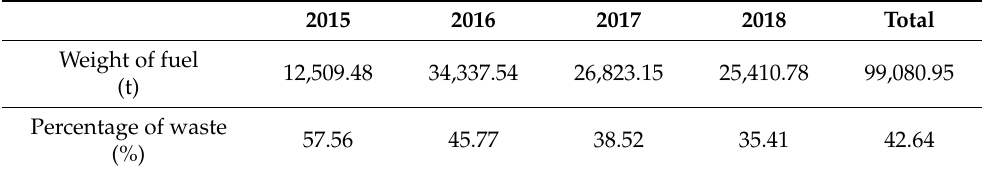
Table 4. Fuel transported to the cement factories and percentage of the lagoon waste.